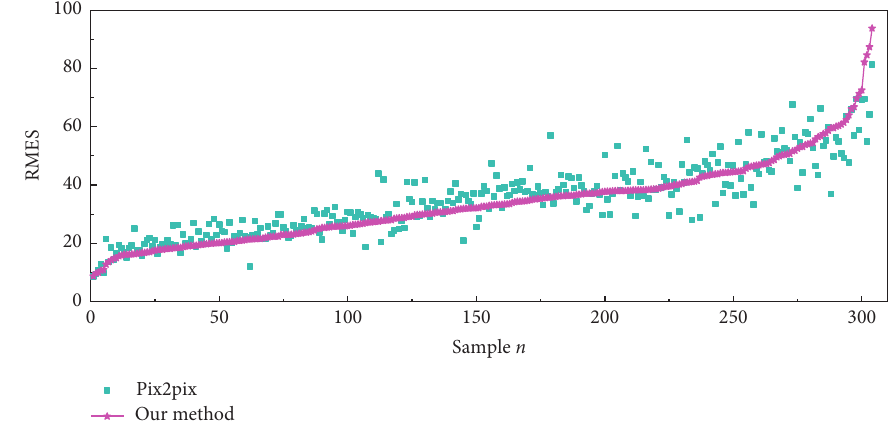
Figure 8: The RMSE results between the real infrared images and the infrared images generated by our method and the Pix2pix. The X -axis represents different test samples and the Y -axis represents the RMSE value corresponding to the sample.